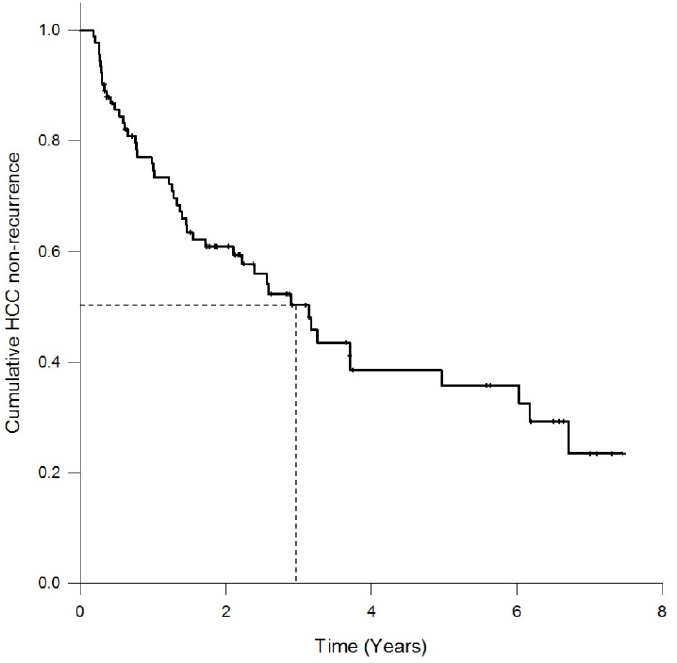
Figure 2. Cumulative HCC non-recurrence curve of patients with hepatocellular carcinoma ( n = 92). The demographic and clinical characteristics of the patients are shown in Table 1. Characteristics of patients with recurrent and non-recurrent hepatocellular carcinoma at pre-resection and post-resection 1 .